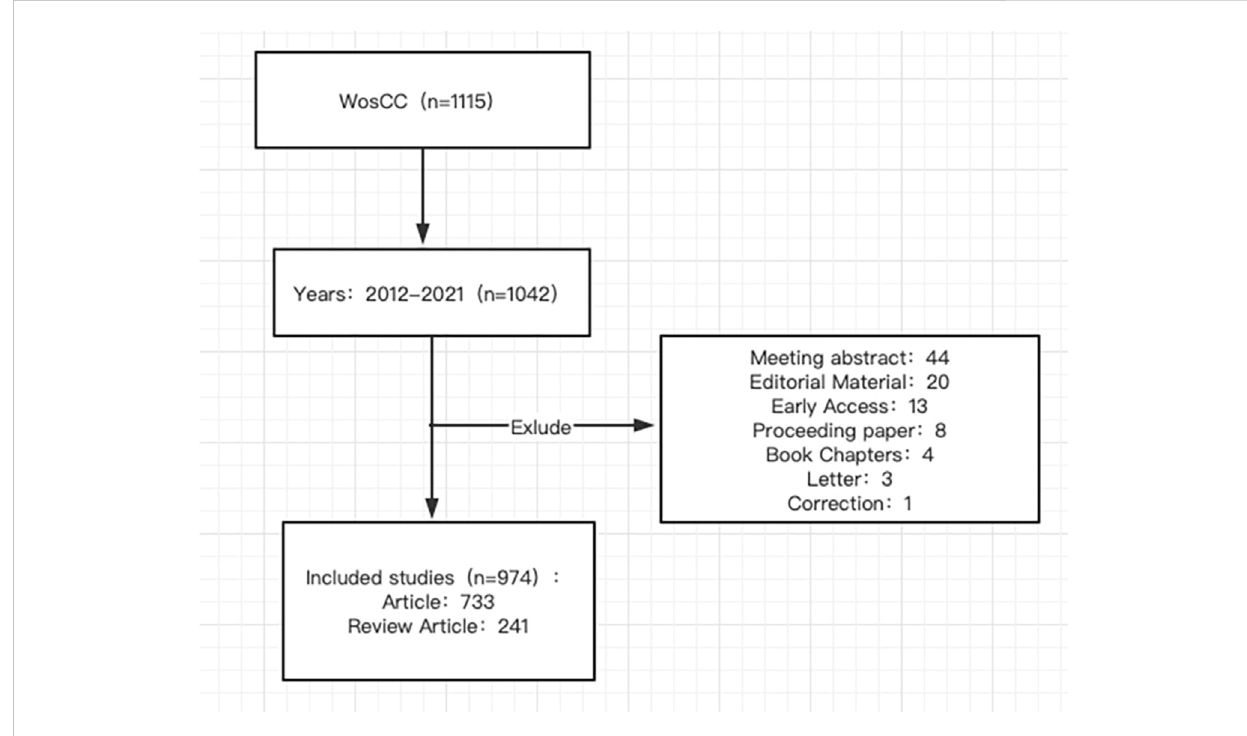
FIGURE 1 Flow diagram of the included articles.